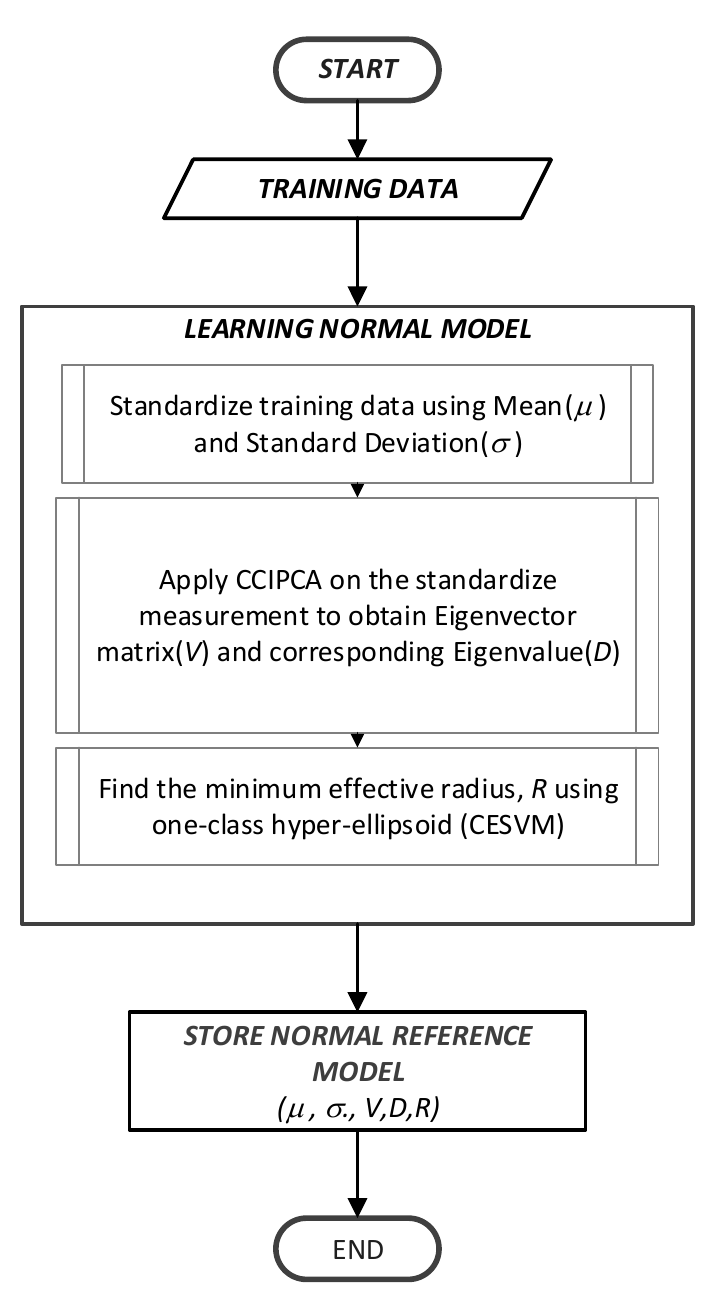
Figure 3 Figure 3. Flowchart of Training Phase for the CESVM-DR Model. The procedures of the training phase are described as